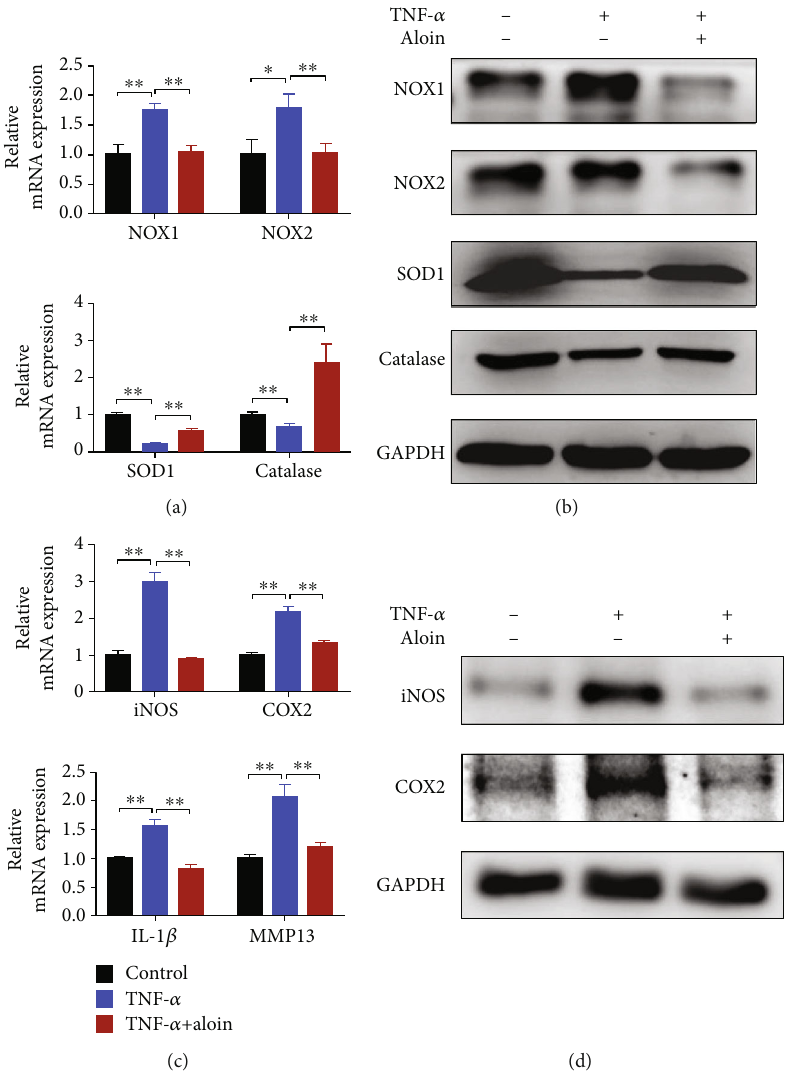
Figure 4: Aloin treatment ameliorates the levels of oxidative stress and proin fl ammatory factors. (a) The mRNA expression levels of NOX1 , NOX2 , SOD1 , and Catalase were detected by qPCR. (b) Protein expression levels of NOX1, NOX2, SOD1, and Catalase were detected by western blotting. (c) The mRNA expression levels of iNOS , COX2 , IL- β , and IL-6 were detected by qPCR. (d) Protein expression levels of iNOS and COX2 were detected by western blotting. In this fi gure, aloin was used at the concentration of 200 μ M, while TNF- α was at the concentration of 10ng/ml. ∗ P < 0 : 05 , ∗∗ P < 0 : 01